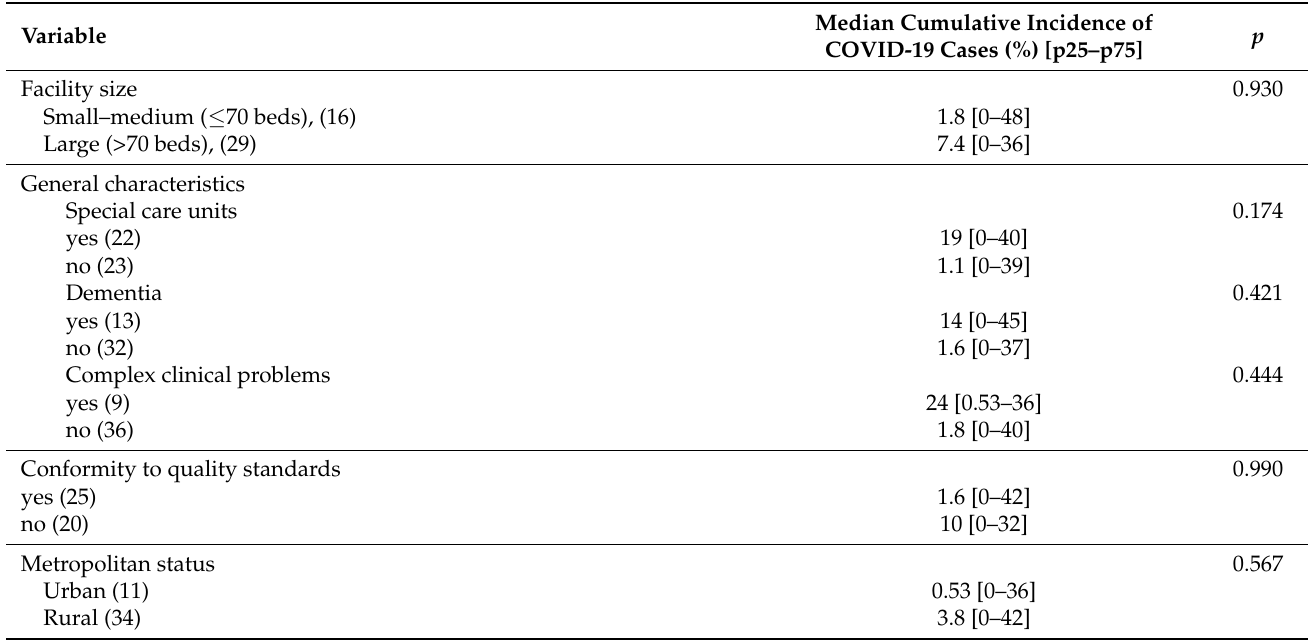
Table 2. Association analyses between median cumulative incidence of COVID-19 cases among residents and characteristics of the nursing homes that participated in the survey (N =